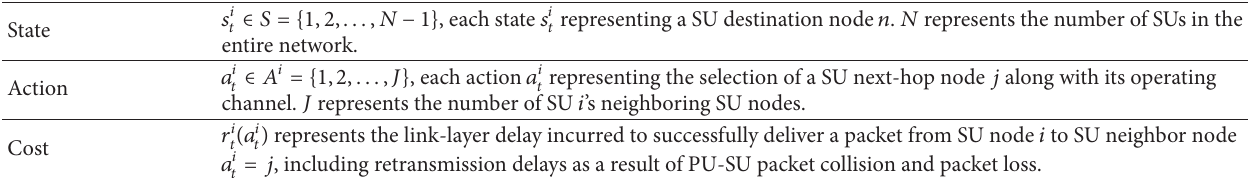
Table 1: CRQ-routing model embedded at SU node 𝑖